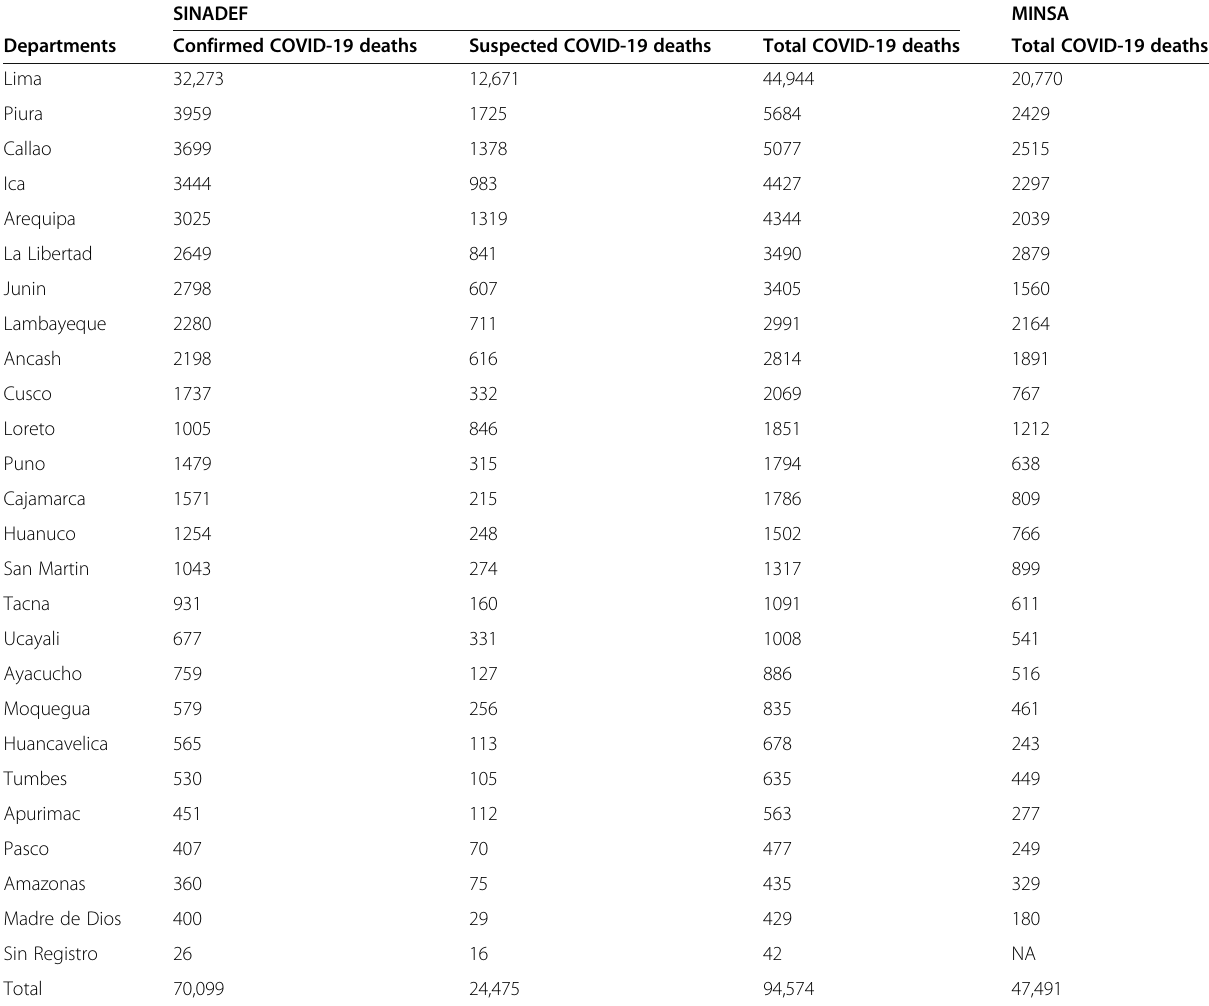
Table 1 Comparison of the reported deaths from COVID-19 between the National Informatics Deaths System (SINADEF) and the Ministry of Health (MINSA) records (during the period from the first reported case of COVID-19 in Peru to March 6, 2021)